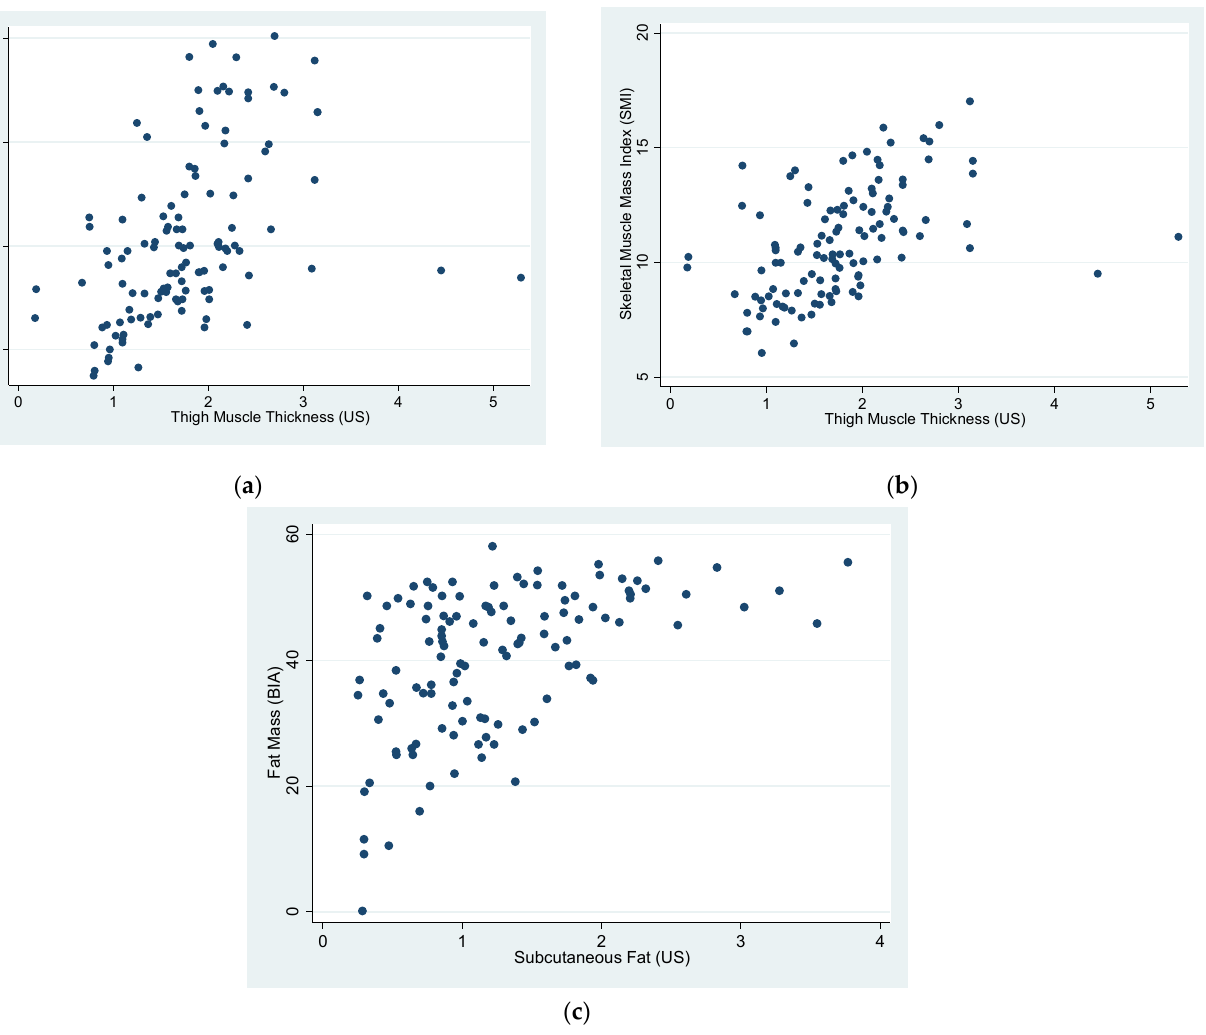
Figure 2. ( a ) A significant correlation was observed between lean mass (LM) by bioelectrical impedance analysis (BIA) and thigh muscle thickness (TMT) by ultrasound (US); ( b ) a significant correlation was observed between skeletal muscle mass index (SMI) assessed by bioelectrical impedance analysis (BIA) and thigh muscle thickness (TMT) assessed by ultrasound; ( c ) a significant correlation was observed between fat mass (FM) assessed by bioelectrical impedance analysis (BIA) and subcutaneous fat (SF) assessed by ultrasound (US). Table 2. Relationship between LM (BIA), TMT (US), and SMI (BIA. Correlations